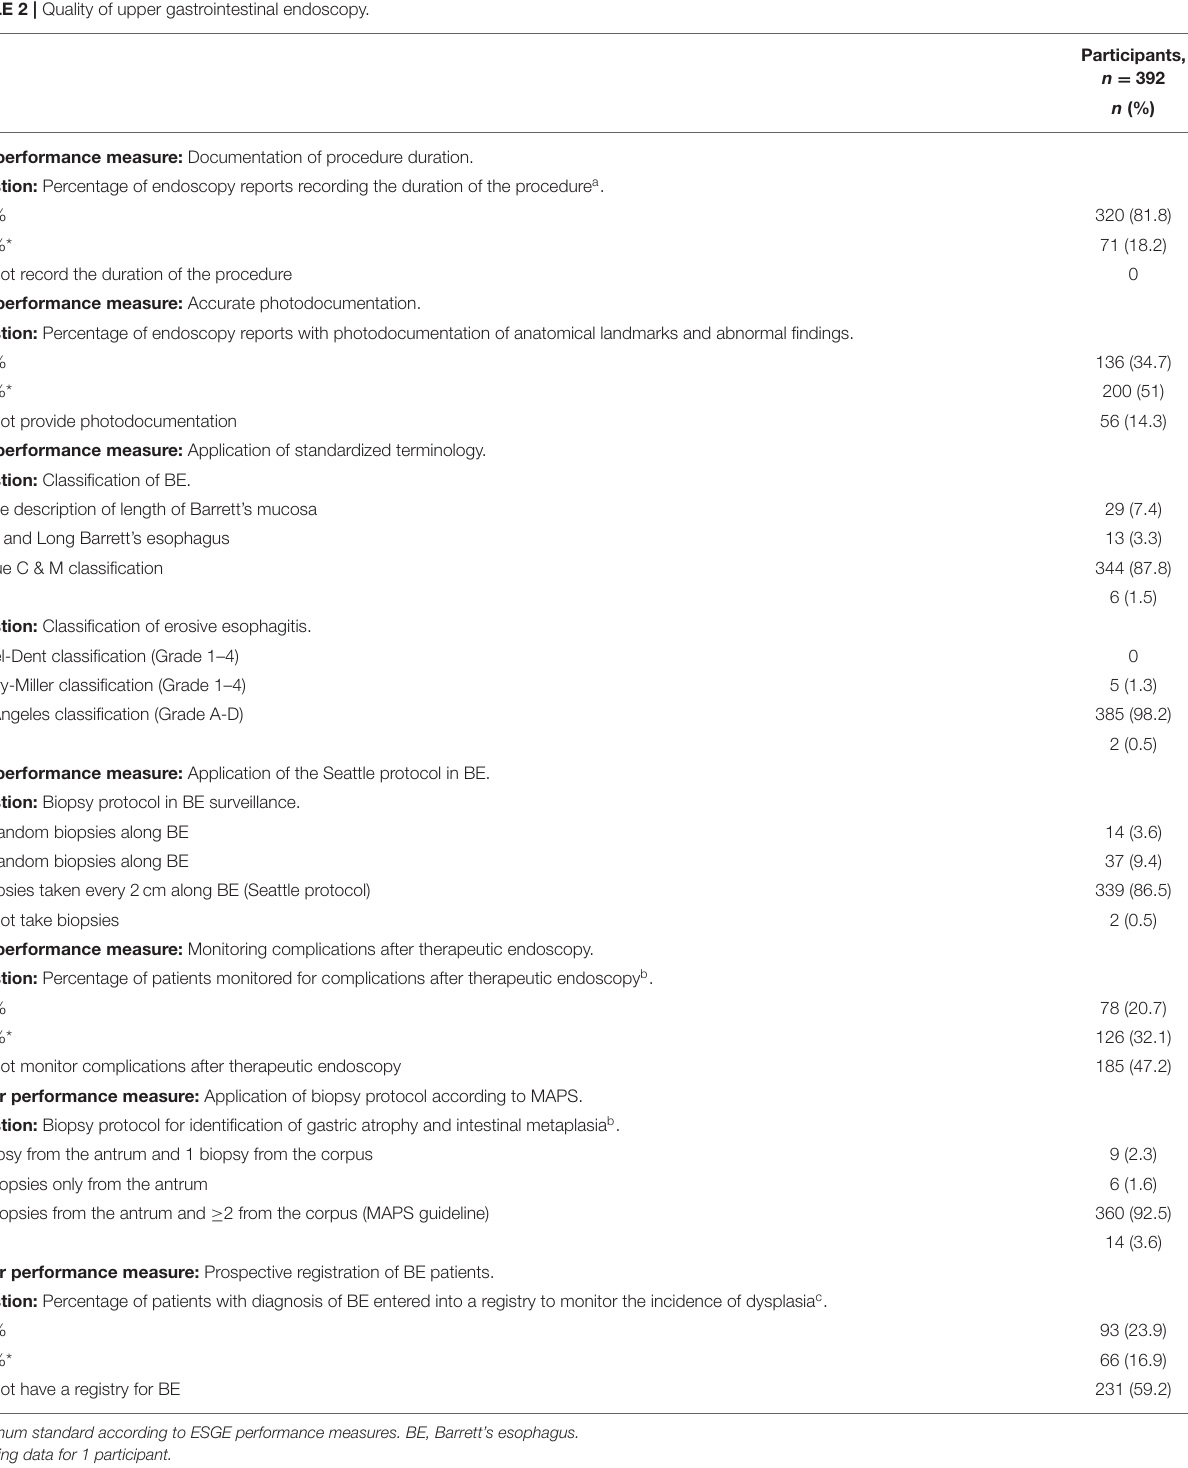
TABLE 2 | Quality of upper gastrointestinal